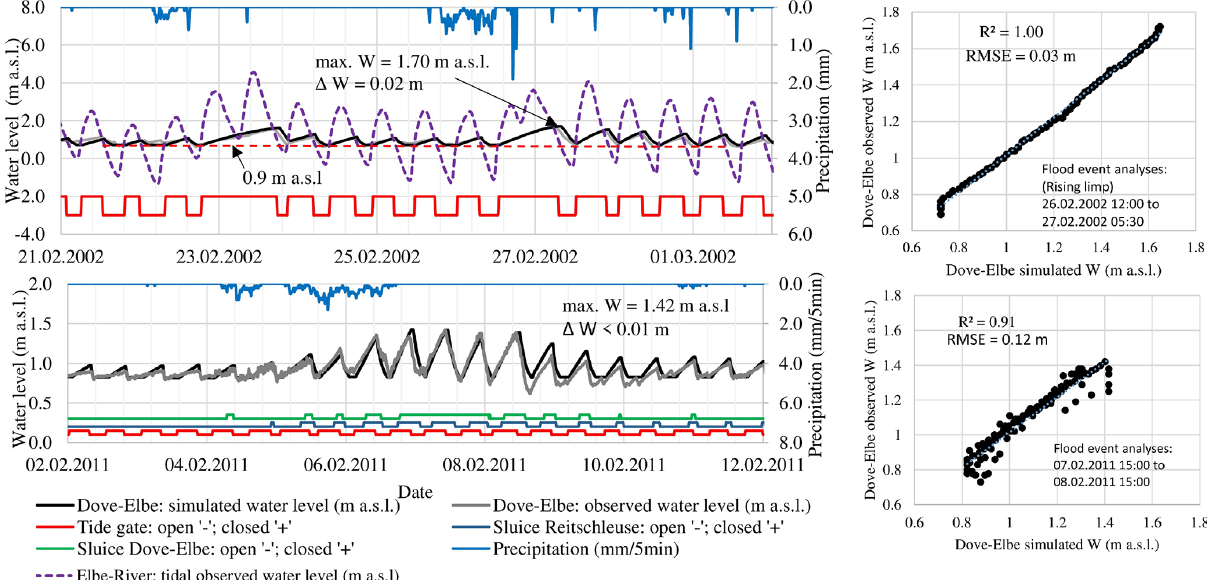
Figure 11. Closure and opening state of the control structures as well as simulated and observed water levels at the downstream gauge Allermöher Deich for the event in February 2002 and February 2011. The tide gate remained closed two times during the storm events in February 2002, meaning that the Elbe River water level during low tide period did not fall below the required minimal water level of 0.9ma.s.l. The simulated and observed water levels depict a difference of 0.02 to 0.01m in a stream with a water table fluctuation of about 1m. The RMSE for the flood event analysis shows a deviation of up to